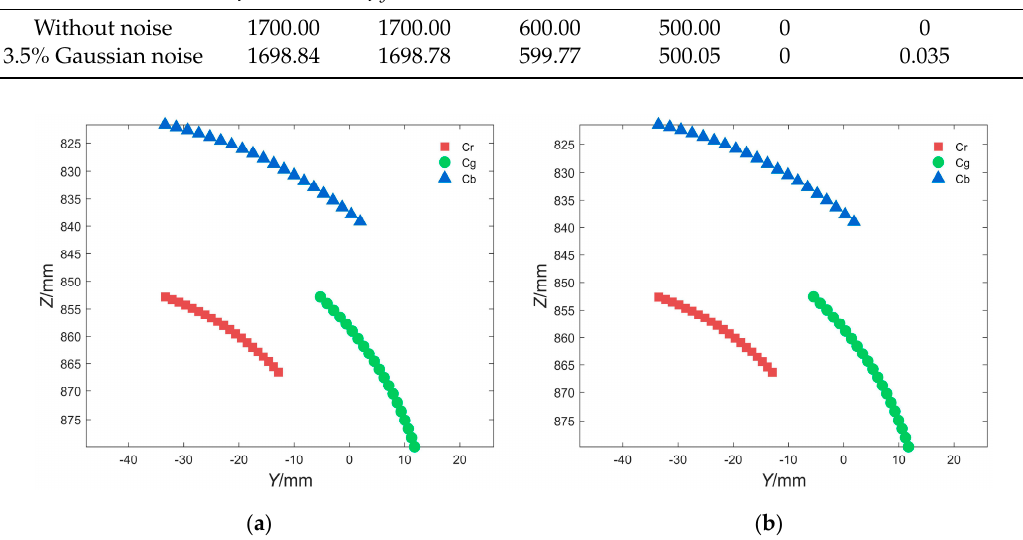
Figure 6. ( a ) Projection of the simulated optical centers on the Y w O w Z w plane without noise; ( b ) projection of the simulated optical centers on the Y w O w Z w plane with 3.5% Gaussian noise.